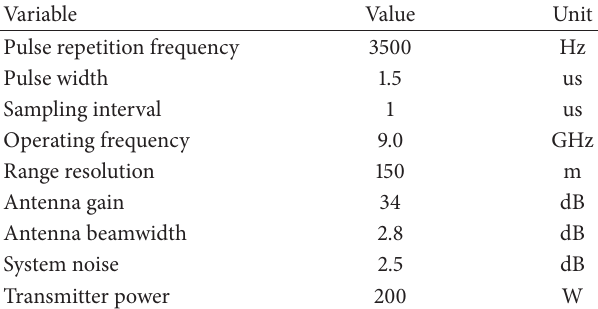
Figure 4: Rain Echo Spectrum Distribution of the first scan line (three-dimensional